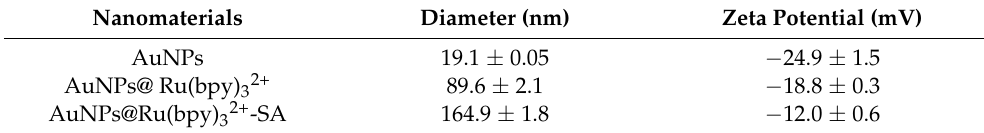
Figure 4. Particle size ( A ) and zeta potential ( B ) distribution of AuNPs and gold nanocomposites (a. AuNPs; b. AuNPs@Ru(bpy) 32+ ; c. AuNPs@Ru(bpy) 32+ -SA). Table 1. Average particle size and zeta potential of AuNPs and the related nanocomposites.